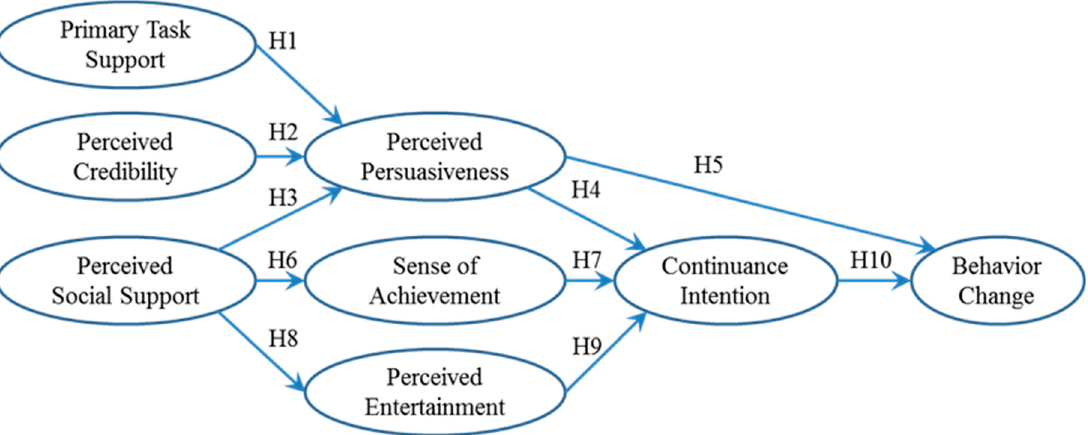
Figure 3. Research Model.